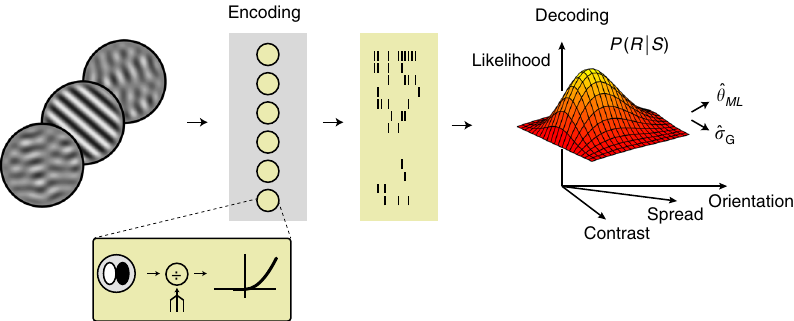
Fig. 7 Decoding population activity. We simulated the activity of V1 populations whose mean fi ring rate and gain variability was governed by the stochastic normalization model. Each unit's stimulus preference and dynamic range was chosen randomly. We used an iterative procedure to decode the most likely stimulus features (orientation, contrast, and spread) from the population activity. The uncertainty receptive fi eld connects these feature estimates to an associated gain variability estimate (Fig. 5b).